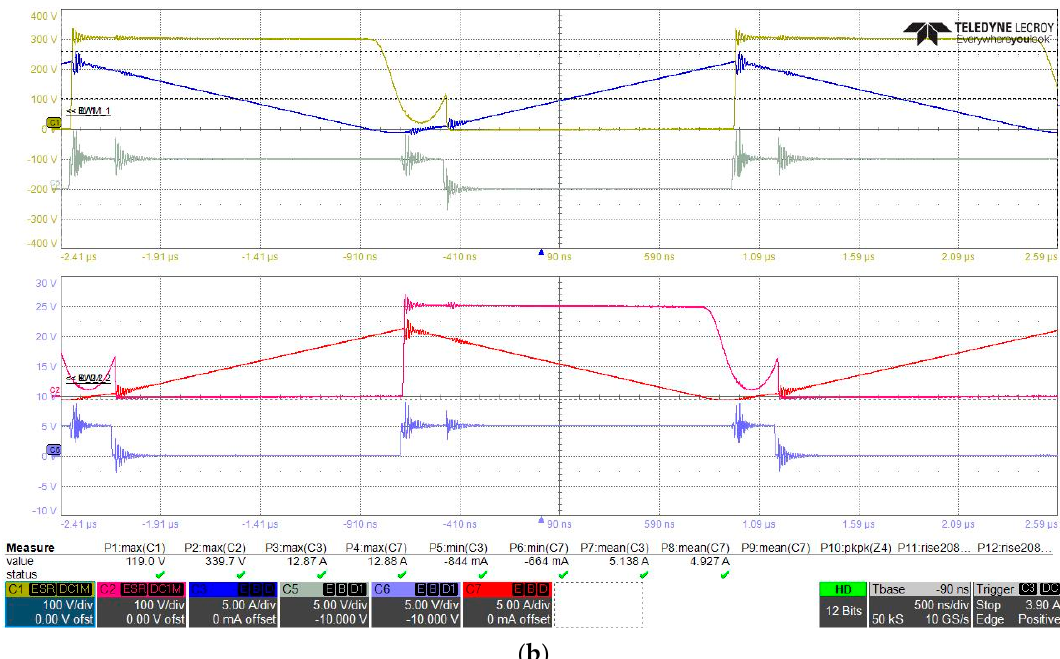
Figure 25. Waveforms for P OUT = 1.5 kW. ( a ) Main waveforms (yellow and purple traces are, respectively, the V DS of the two power devices, red and blue traces are the inductors currents, grey and light blue traces represent the two driving PWM signals; ( b ) magnification of a single period. Figure 26a,b show the measurements of the V DS ringing frequency and overshoot am- plitude, being equal to 65.8 MHz and 34 V (11% overshoot), respectively. From the fre- quency measurement, considering an output capacitance in the tens of nF range, the PCB stray inductance order of magnitude is tens of nH.